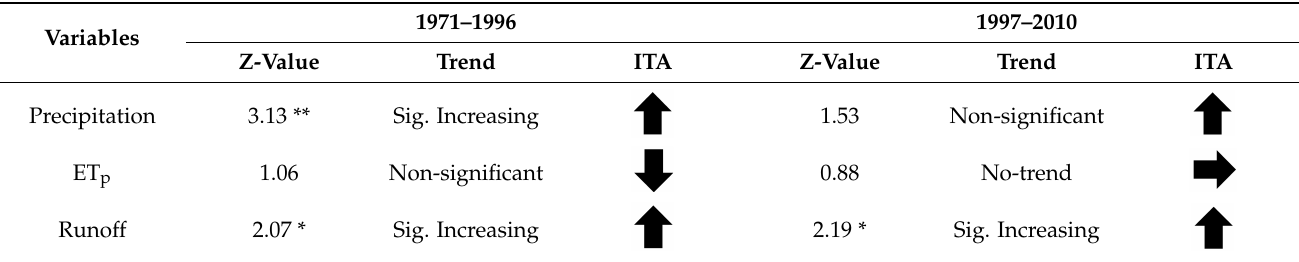
Table 7. Results of the MK trend test and ITA on the hydro-climatic variables of the KRB during the pre and post-change periods.